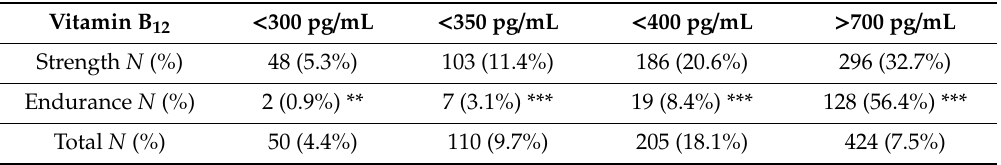
Table 1. The number and percentage of samples of the strength and endurance athletes with vitamin B 12 concentration below 300, 350 and 400 pg / mL and above 700 pg / mL. Vitamin B 12 < 300 pg / mL < 350 pg / mL < 400 pg / mL > 700 pg / mL Strength N (%) 48 (5.3%) 103 (11.4%) 186 (20.6%) 296 (32.7%) Endurance N (%) 2 (0.9%) ** 7 (3.1%) *** 19 (8.4%) *** 128 (56.4%) *** Total N (%) 50 (4.4%) 110 (9.7%) 205